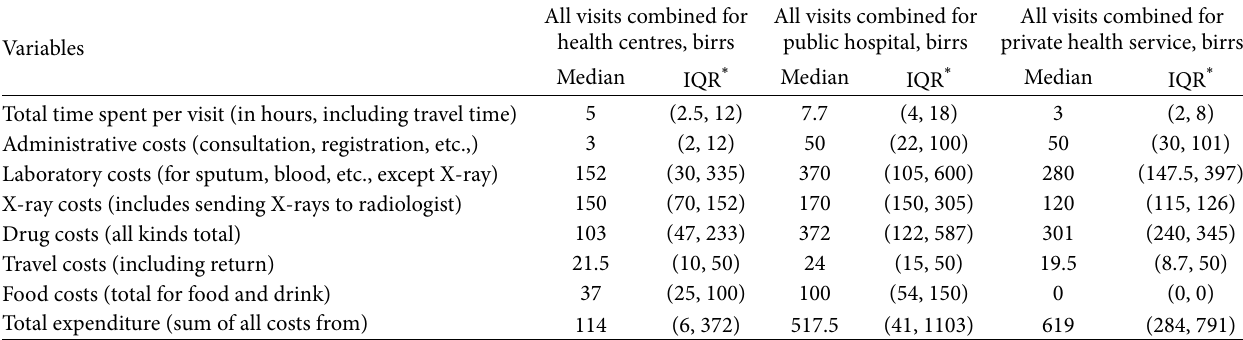
∗ IQR = Inter quartile range.